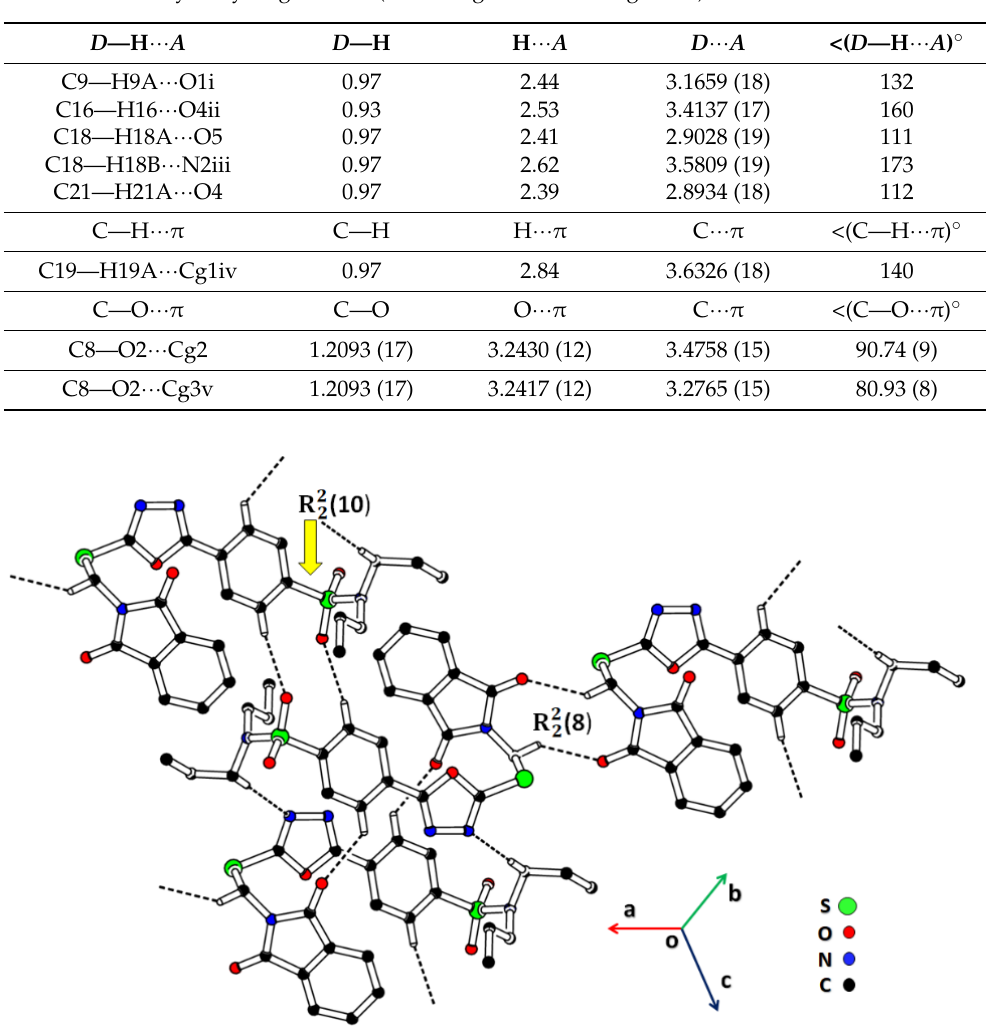
Figure 3. Packing diagram of PESMP elucidates the interlinkage of the molecules via C-H · · · O and C-H · · · N bondings. Only selected hydrogen atoms are shown to avoid ambiguity.